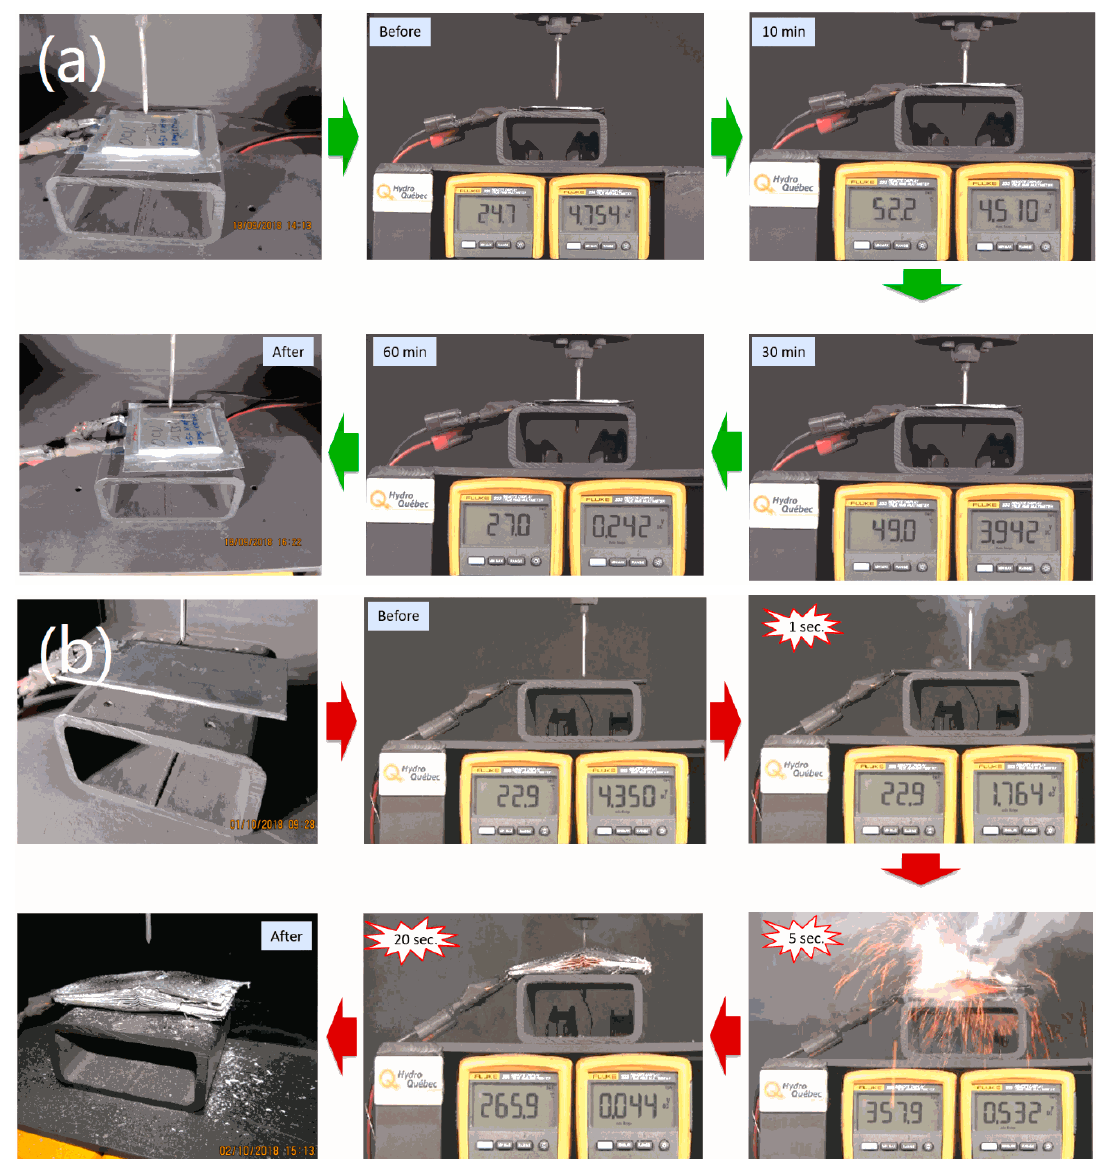
Figure 2. A Photographs, temperature and voltage change of the 1.2 Ah LCP ( a ) and iPhone ( b ) pouch cells before, during, and after the nail penetration test.